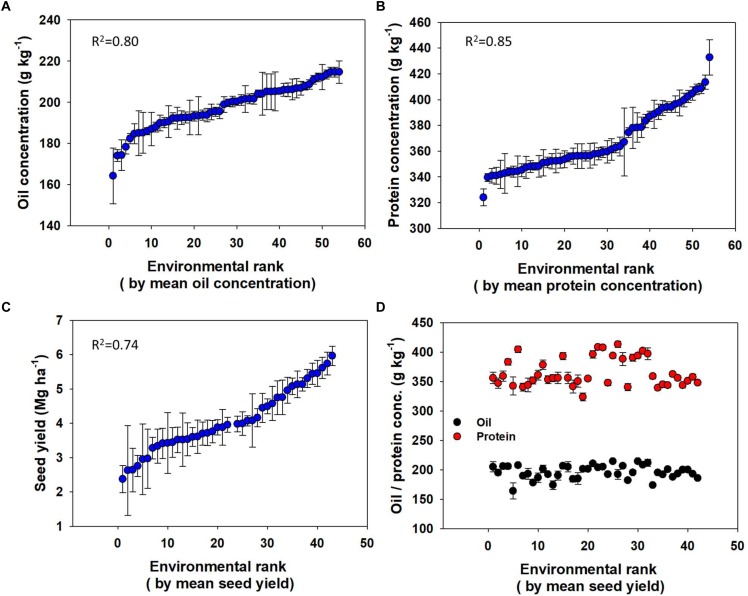
Variation in oil concentration (A), protein concentration (B), and seed yield (C) across environments each ranked with respective variables and oil and protein concentration (D) across Es ranked with mean seed yield.